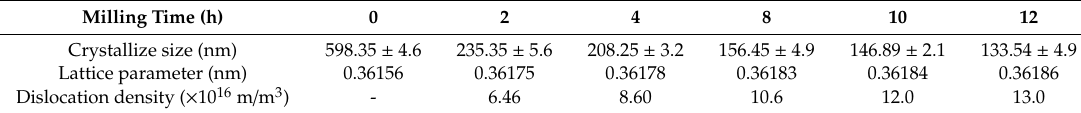
Table 2. Variations in the crystallize size, lattice parameter and dislocation